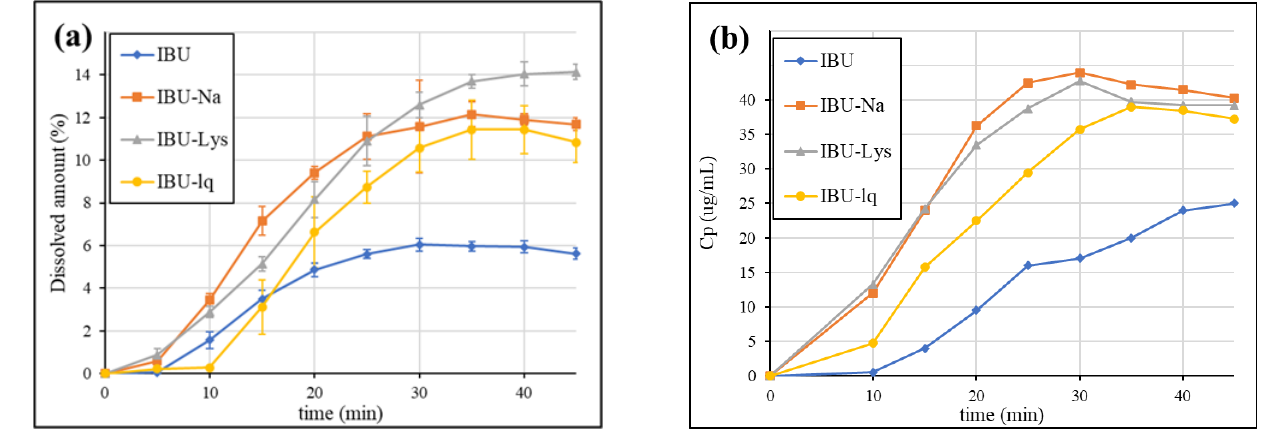
Figure 6. GIS duodenal dissolution in blank biorelevant media ( a ) vs. fasting BA study results ( b ) [23]. ( b )